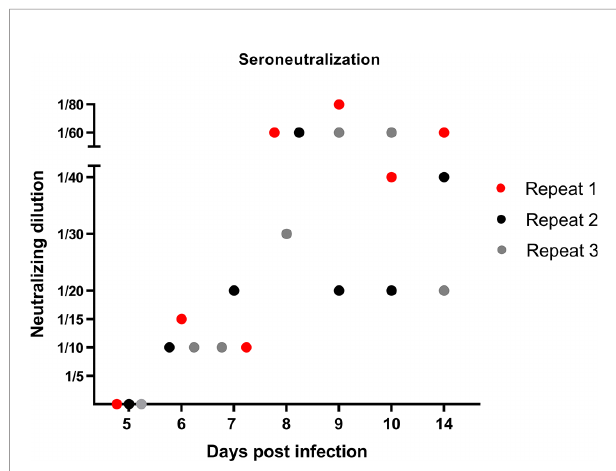
FIGURE 3 | Neutralizing antibody response in JEV-infected pigs. VNT tests were performed to quantify the amount of JEV-speci fi c neutralizing antibodies in the serum of 9-week-old pigs upon intradermal inoculation with 10 5 TCID 50 .